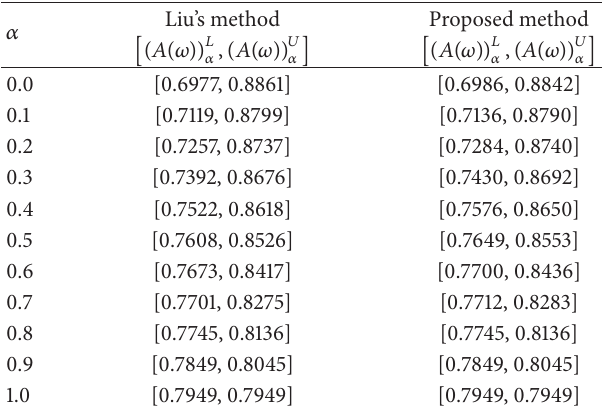
Table 4: The 𝛼 -cut of the fuzzy steady-state availability values.